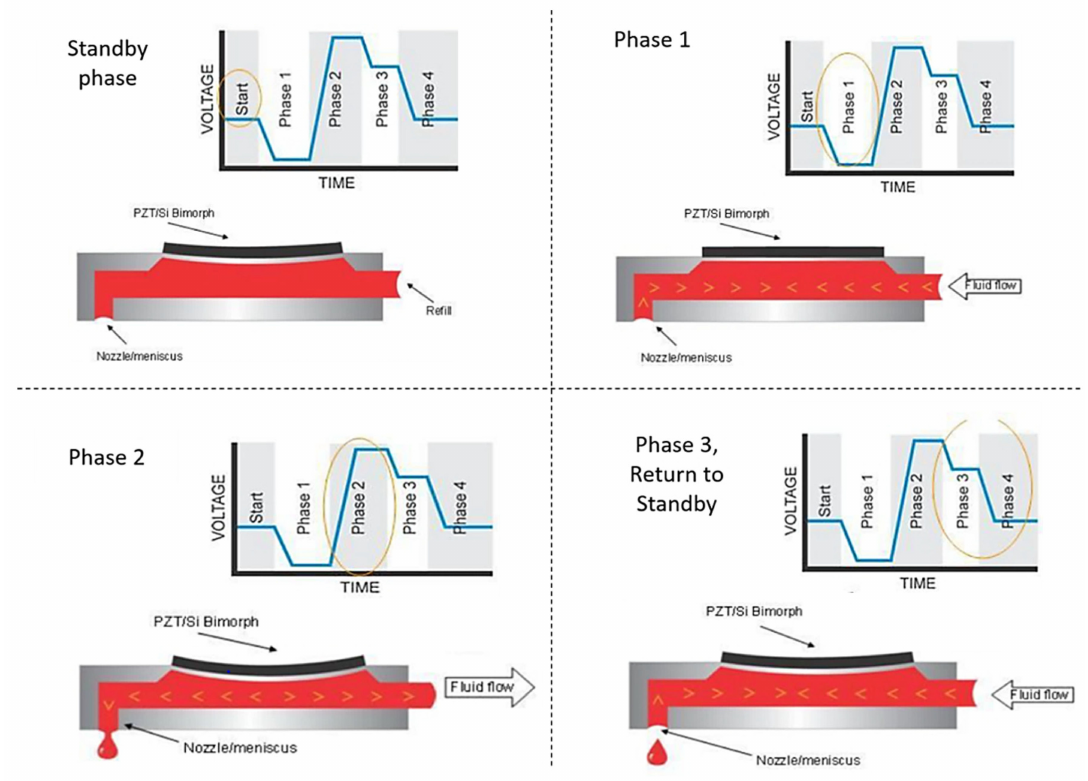
Figure 2. Different phases of the waveform experienced at the cartridge printhead